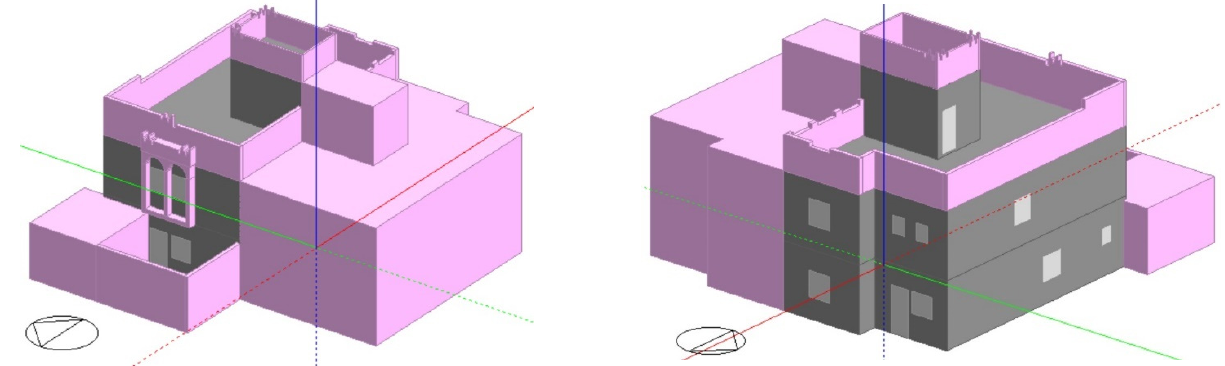
Figure 3. T3M residential unit DesignBuilder building model.